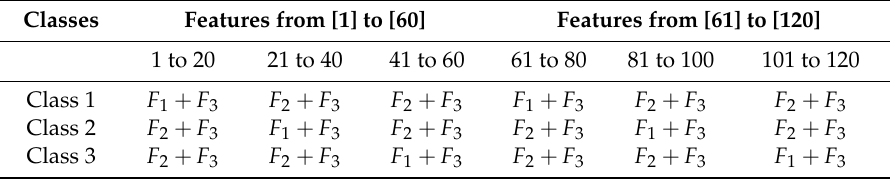
Table 1. Structure of dataset 1.